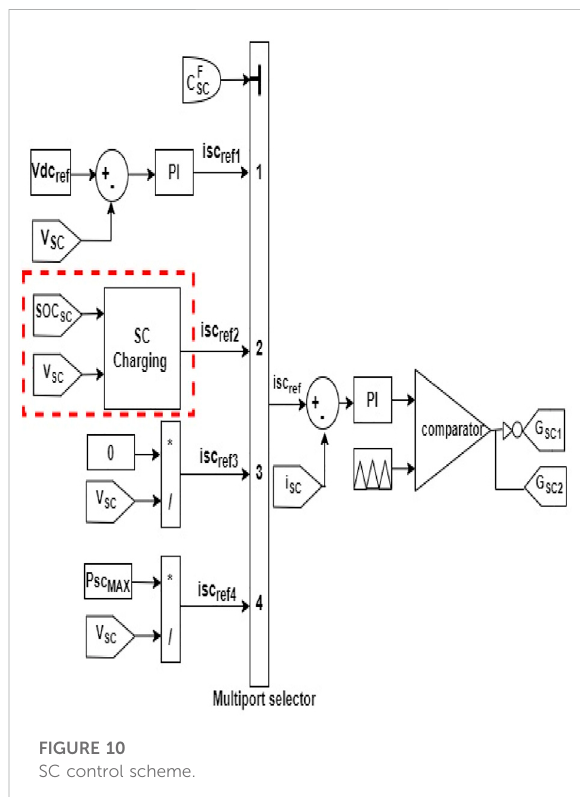
FIGURE 10 SC control